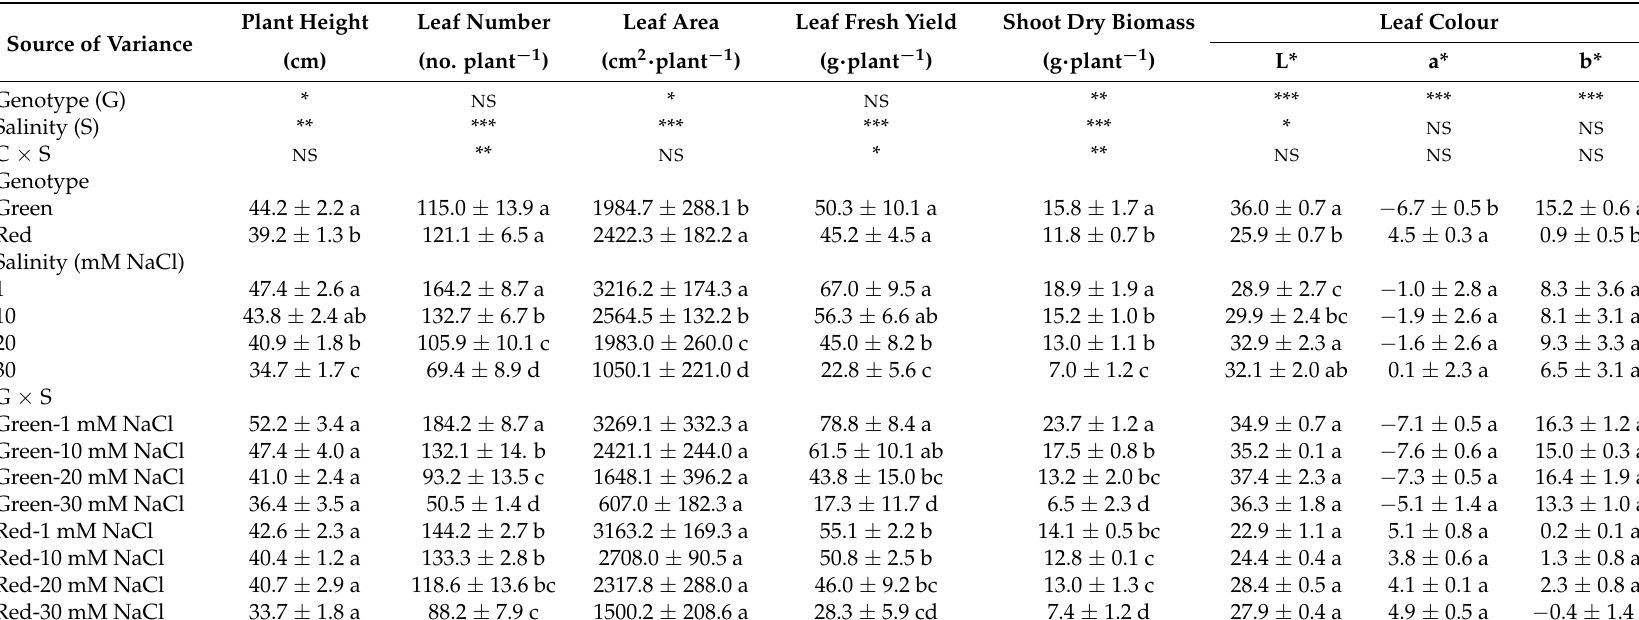
Table 1. Analysis of variance and mean comparisons for plant height, number of leaves per plant, total leaf area, leaf fresh weight, shoot dry biomass, and leaf colour: L* (brightness), a* (+a* = red; − a* = green) and b* (+b* = yellow; − b = blue) in green and red perilla grown under increasing NaCl concentration in the nutrient